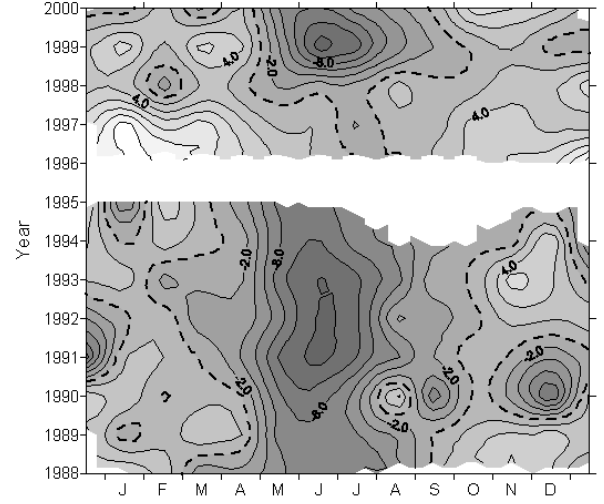
Fig. 4. Monthly-mean zonal winds (ms − 1 ), 1988–2000. The zero wind line is indicated by the heavy dashed contour.